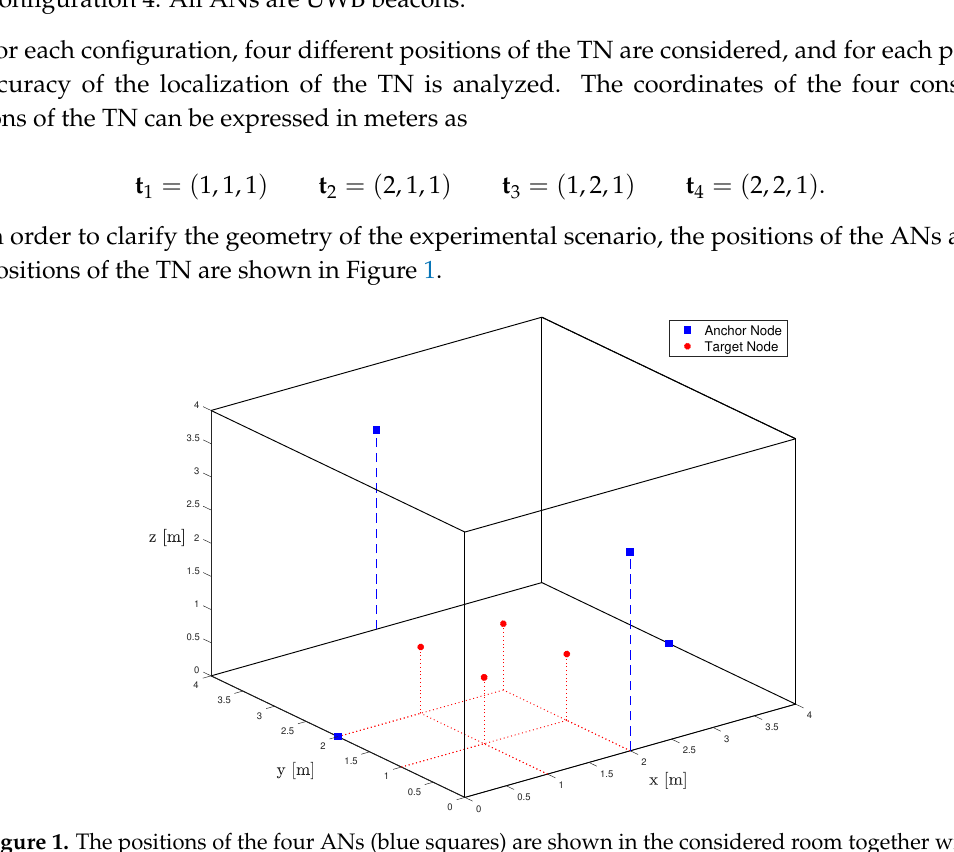
Figure 1. The positions of the four ANs (blue squares) are shown in the considered room together with the four positions of the TN (red